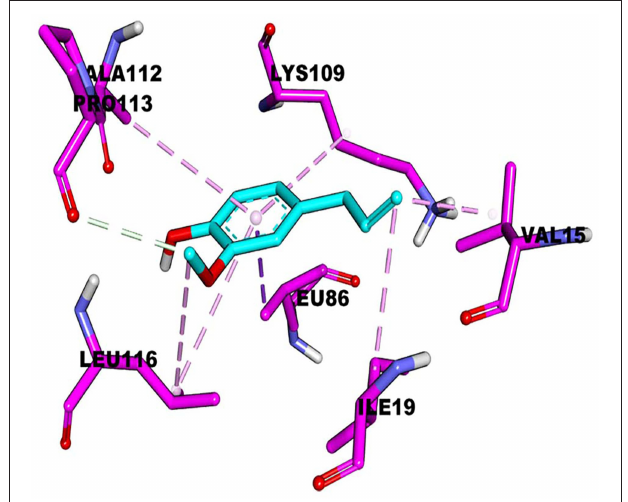
FIGURE 4 | Molecular docking of eugenol with